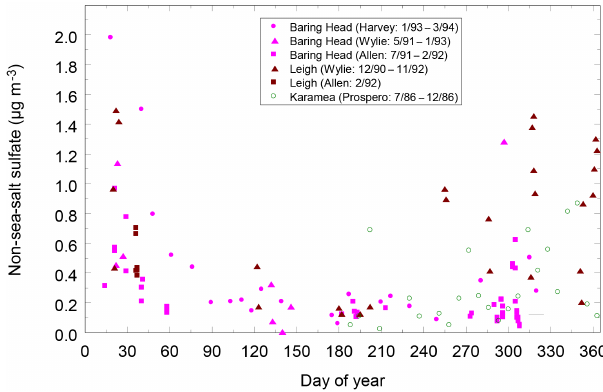
Figure 2. Non-sea-salt sulfate concentrations plotted against day of year at different New Zealand coastal atmospheric monitoring